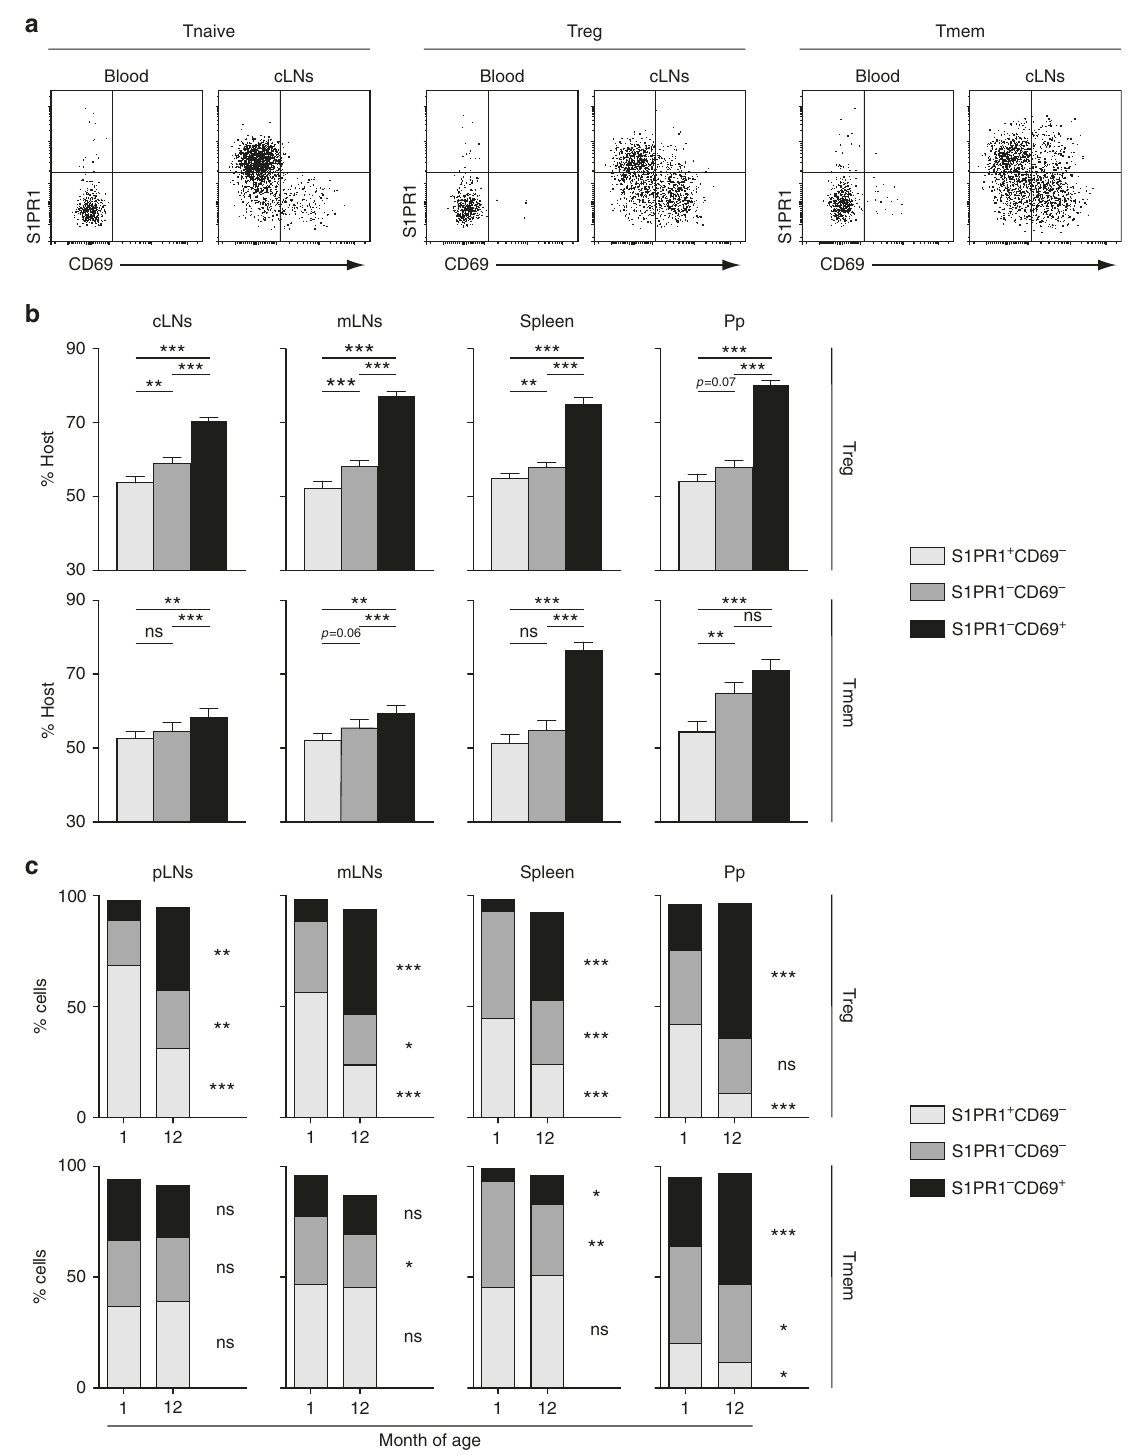
Fig. 7 S1PR1 downregulation account for T cell residence in SLOs. a , b Four weeks after parabiosis surgery, blood, cervical LNs (cLNs), mesenteric LNs (mLNs), spleen, and Peyer ’ s patches (Pp) were recovered and analyzed. a S1PR1/CD69 representative dot-plots are shown for blood and cLN CD4 Treg, Tmem, and Tnaive cells from a representative parabiont. b Proportions of host cells (CD45.1 + for the CD45.1 parabiont and CD45.2 + for the CD45.2 parabiont) among the indicated CD4 Treg (upper panel) and Tmem (lower panel) cell-subsets recovered from cLNs, mLNs, spleen, and Peyer ’ s patches (Pp) are shown as means ± SEM with paired t -test for six parabiotic pairs from three independent experiments. c pLNs, mLNs, spleen, and Peyer ’ s patches (Pp) of 1- and 12-month-old mice were recovered and analyzed. Proportion of the indicated CD4 Treg (upper panel) and CD4 Tmem (lower panel) cell- subpopulations are shown as means with unpaired t -test. * p < 0.05, ** p < 0.01, *** p < 0.001. ns not signi fi